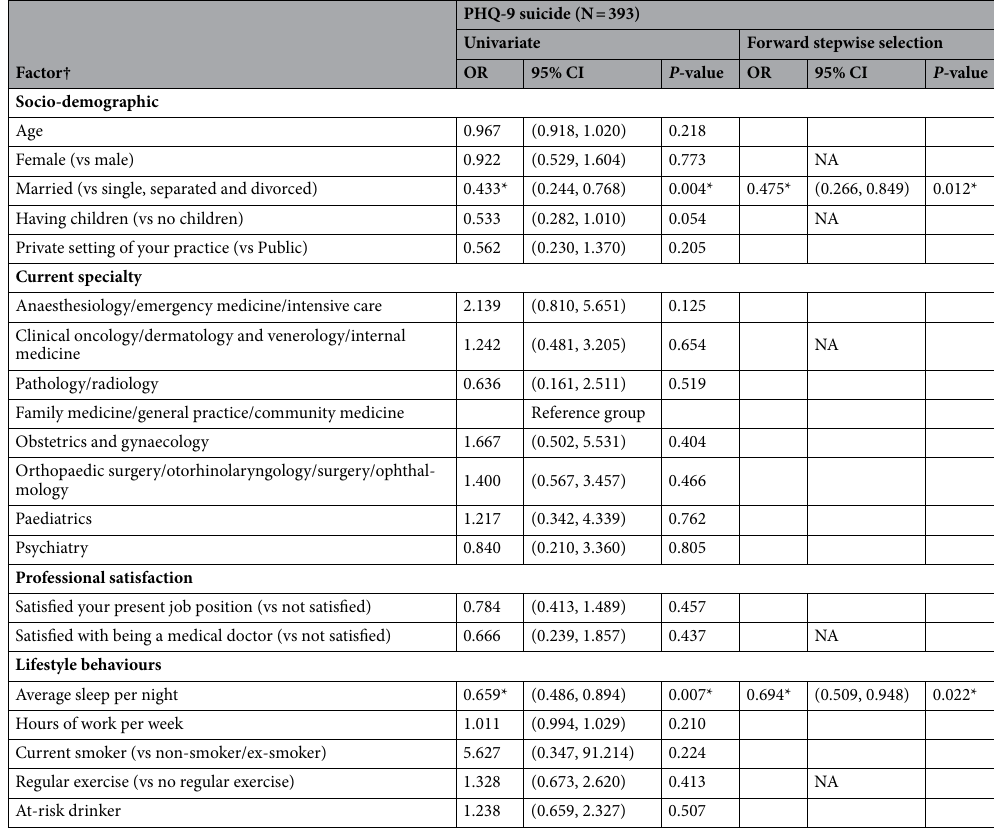
Table 4. Sociodemographic, professional satisfaction and lifestyle behaviour associated with PHQ-9 suicide score by regression analysis. CI = Confidence Interval; OR = Odds Ratio; NA = Not Applicable. Current Smoker (Current smoker vs Non-smoker/ex-smoker). Regular exercise (5 or more days per week for at least 10 min per day/Any vigorous and moderate physical activities). Private Practice (Private Solo/ Private Hospital/ Non-government organisation). Public Practice (University/Government/Hospital Authority/Not applicable). At-risk drinkers were defined if the doctors had 3 or more in AUDIT-C score. * Significant with P -value < 0.05. † Variable in brackets is the reference category for independent variables.